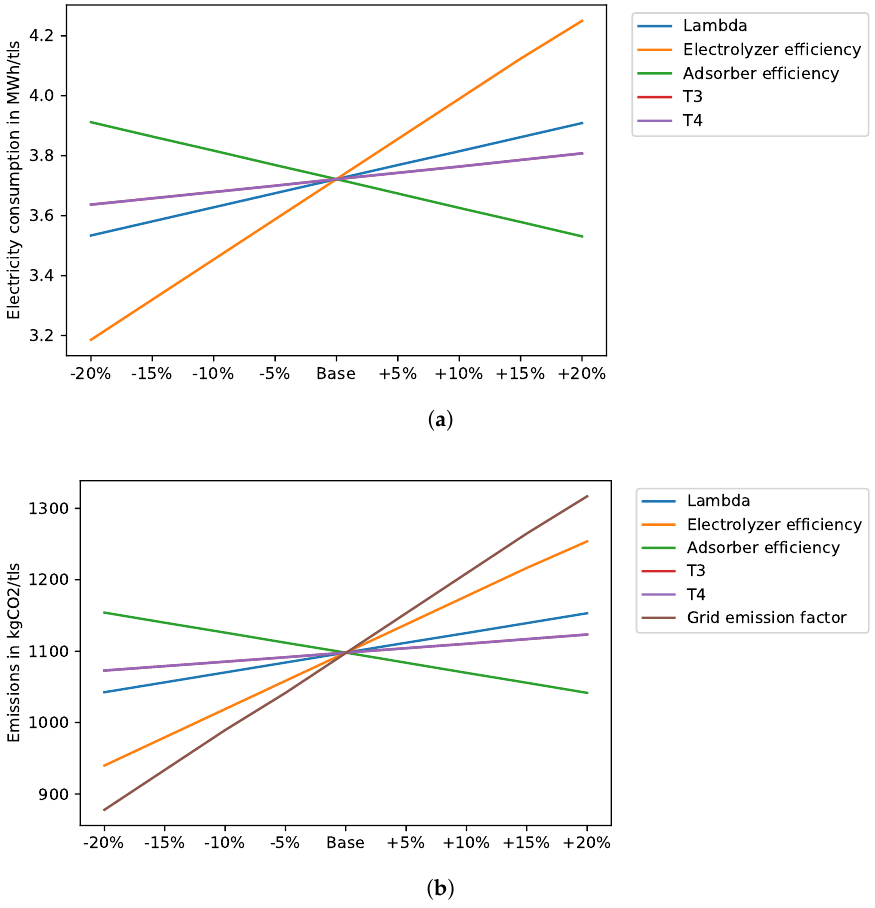
Figure 14. ( a ) Sensitivity analysis to identify the parameters affecting the electricity requirements of the HDRI-EAF system. ( b ) Sensitivity analysis to identify the most important parameters affecting the CO 2 emission from the HDRI-EAF